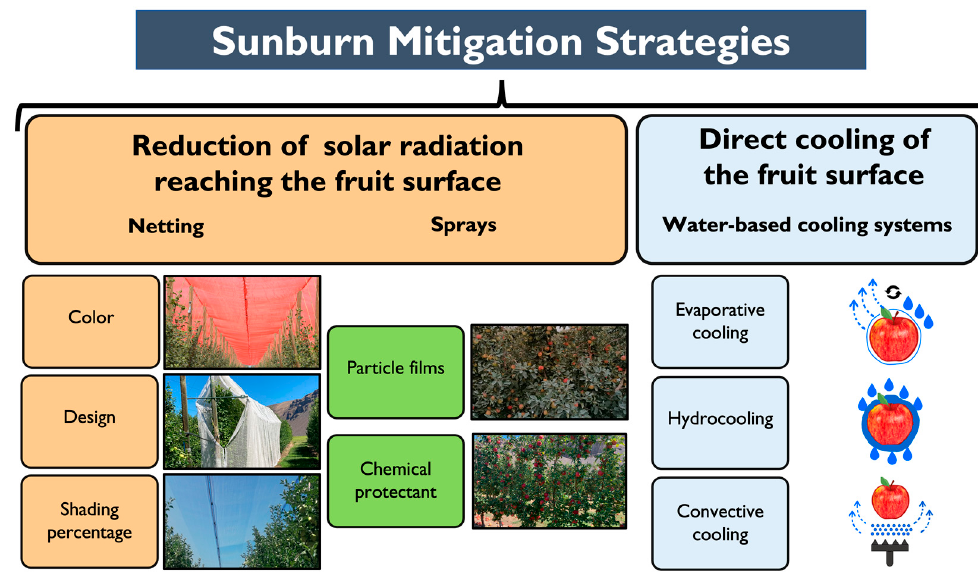
Figure 2. Sunburn mitigation strategies that reduce solar radiation reaching the fruit surface or reduce the temperature of the fruit through cooling.